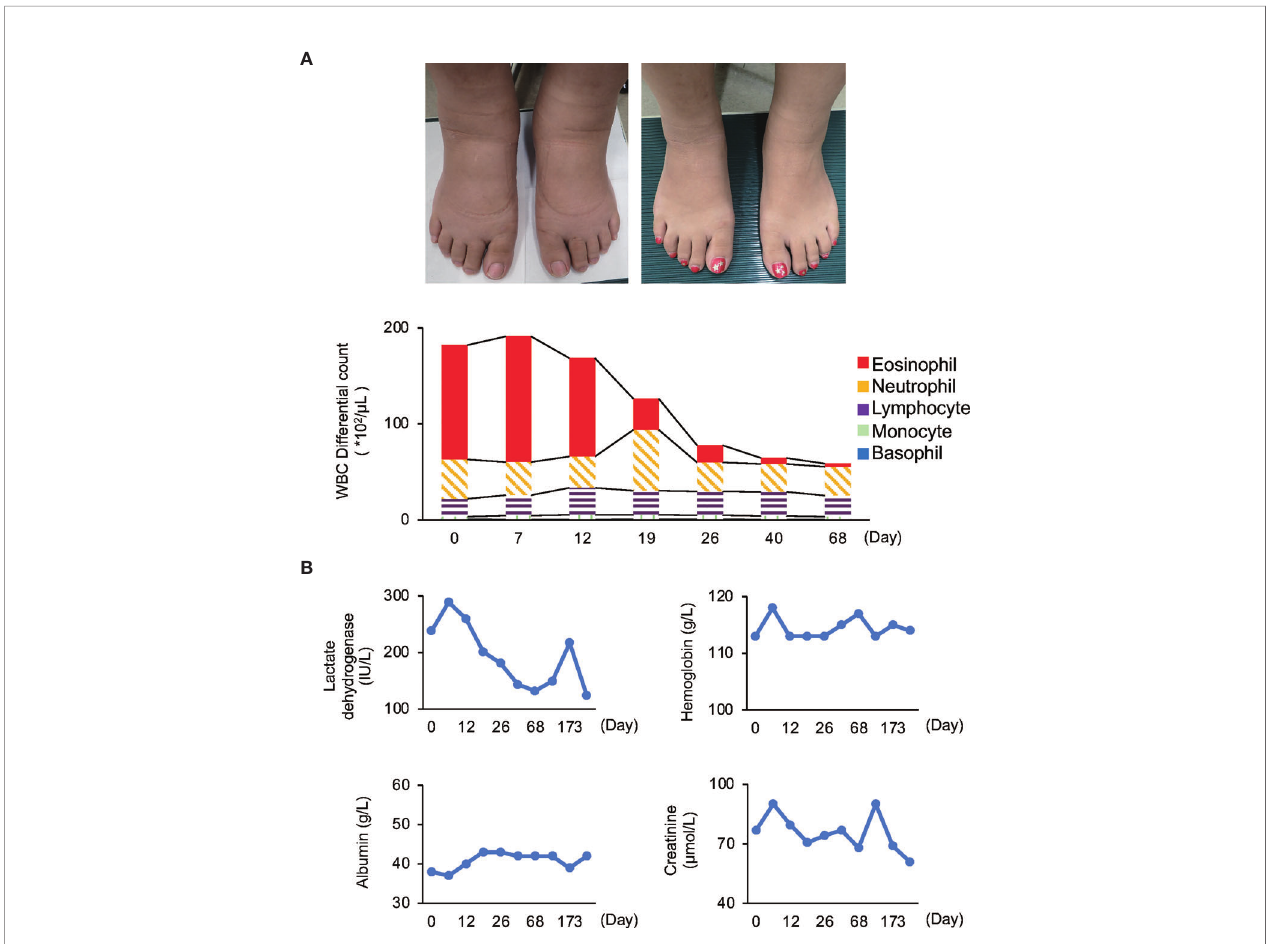
FIGURE 1 | Time series of various examinations (A) White blood cell (WBC) differential count; Patient ’ s feet upon examination (right panel: edematous, left panel: recovery). Both white blood cell and eosinophil counts reached their peak on day 7. (B) Investigations: Lactate dehydrogenase was slightly elevated in the initial stage, but soon normalized. The reference range for LDH is 110-220 IU/L. Other investigations were within normal range through the course of